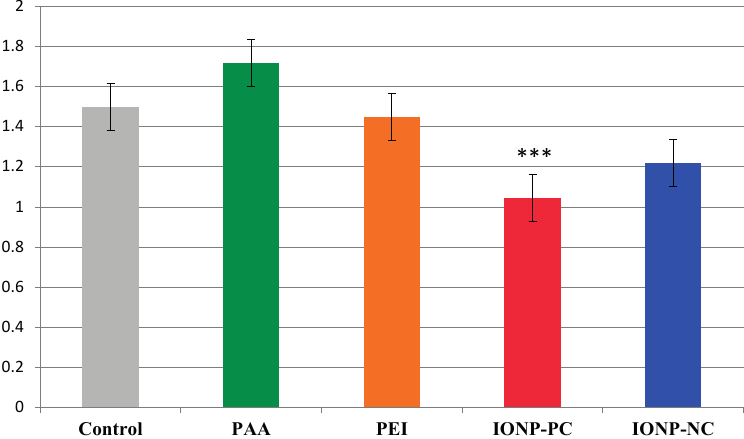
Figure 2. Effect of IONP treatment on overall seedling length in A. thaliana . Mean seedling length of plants grown on agar media containing either IONP-PC (red), IONP-NC (blue), PAA only (green) or PEI only (orange) compared with agar control (gray). A. thaliana Col-0 seeds were grown in MS media supplemented with IONPs at 25 mg/L and PEI or PAA at 12.5 mg/L. Seedling lengths were measured six days after planting. Treatments marked with asterisks were significantly different from the control with p < 0.0001. For all treatments n = 140